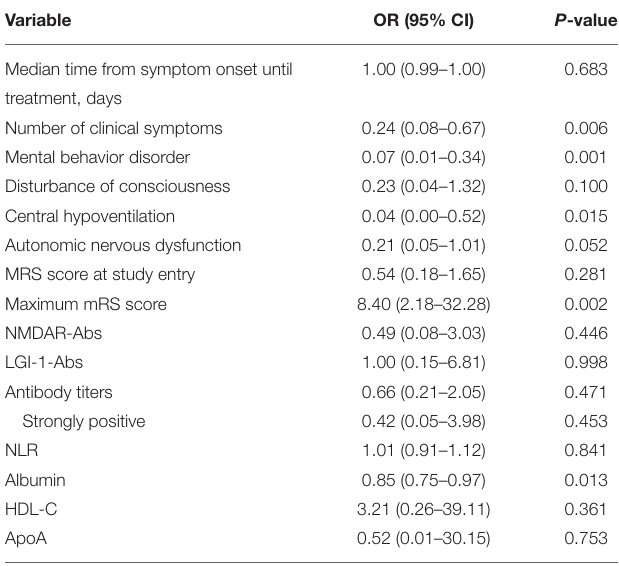
TABLE 2 | Multivariate analysis of factors associated with poor short-term first-line treatment response.